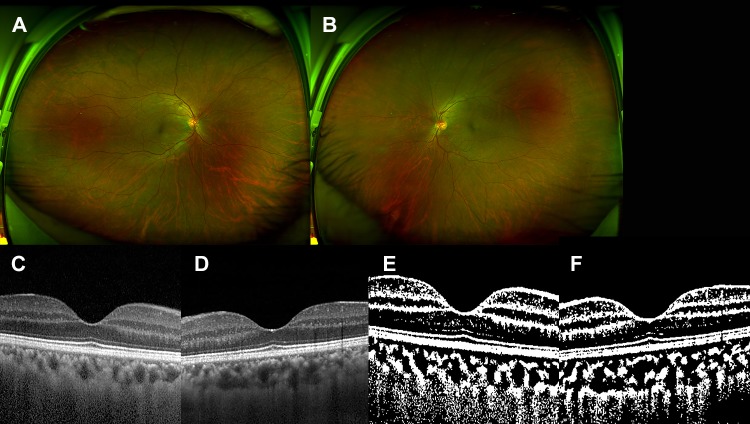
The 53-year-old male patient with symptomatic carotid artery stenosis.He had past history of hypertension and cerebrovascular attack, and severe stenosis of right carotid artery at the time of presentation. (A and B) There was no significant finding in the right eye (A) and the left eye (B). (C and D) Spectral domain optical coherence tomography showed no significant sign in both eyes (C, right eye and D, left eye). The mean subfoveal choroidal thickness by spectral domain optical coherence tomography was 187.0 μm in the right eye and 244.0 μm in the left eye. (E and F) After binarization, (E) the choroidal area was 503,200.0 μm2 and the luminal area was 316,100.5 μm2 in the right eye. (F) The choroidal area was 690,300.5 μm2 and the luminal area was 471,000.0 in the left eye.